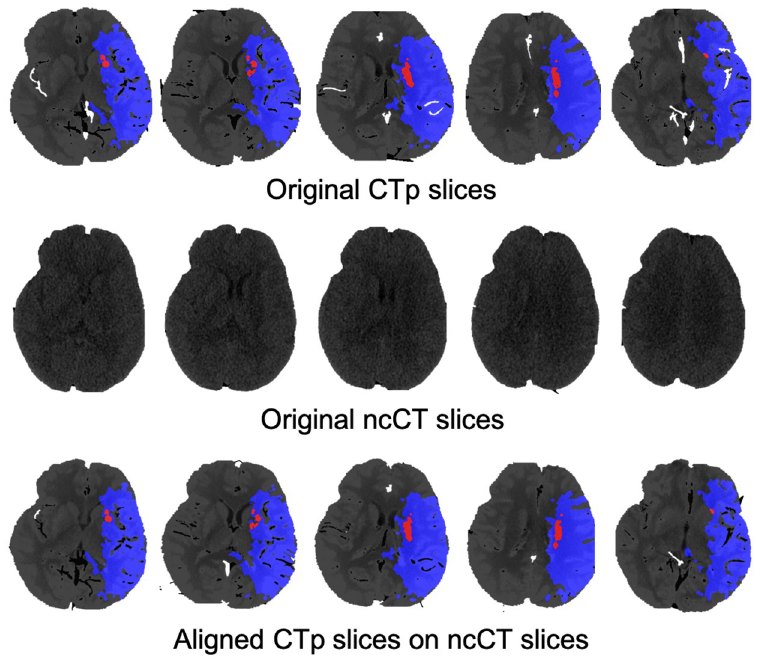
Fig 3. CTp with the ground truth, ncCT aligned with the